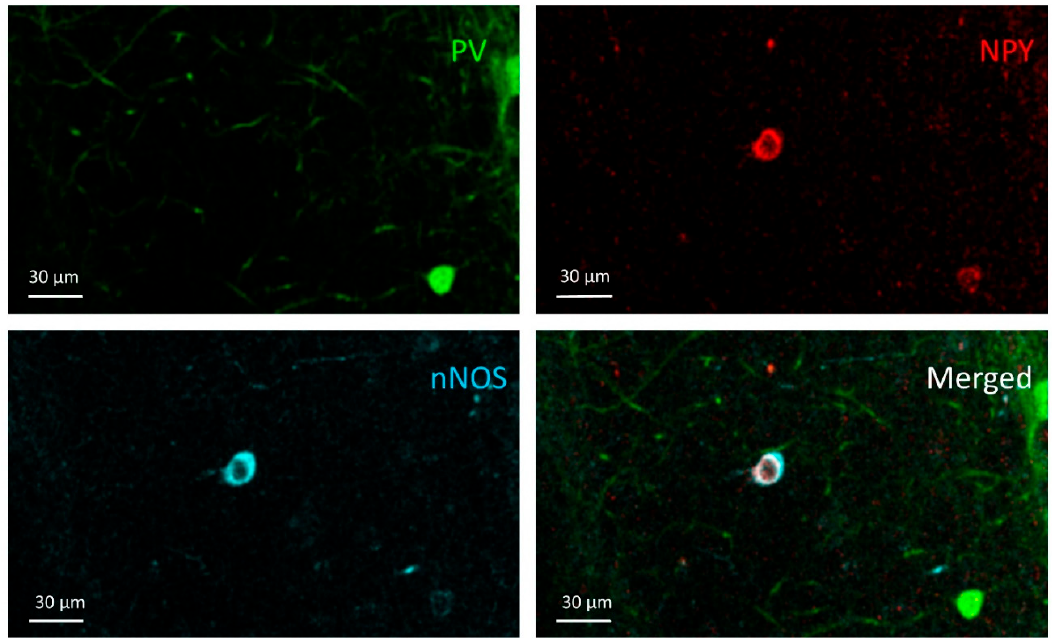
Figure 8. NPY+/nNOS+ cell; An NPY+/nNOS+ cell can be seen in the NPY and nNOS channel images in the stratum radiatum of the CA1, but it does not appear in the PV channel.